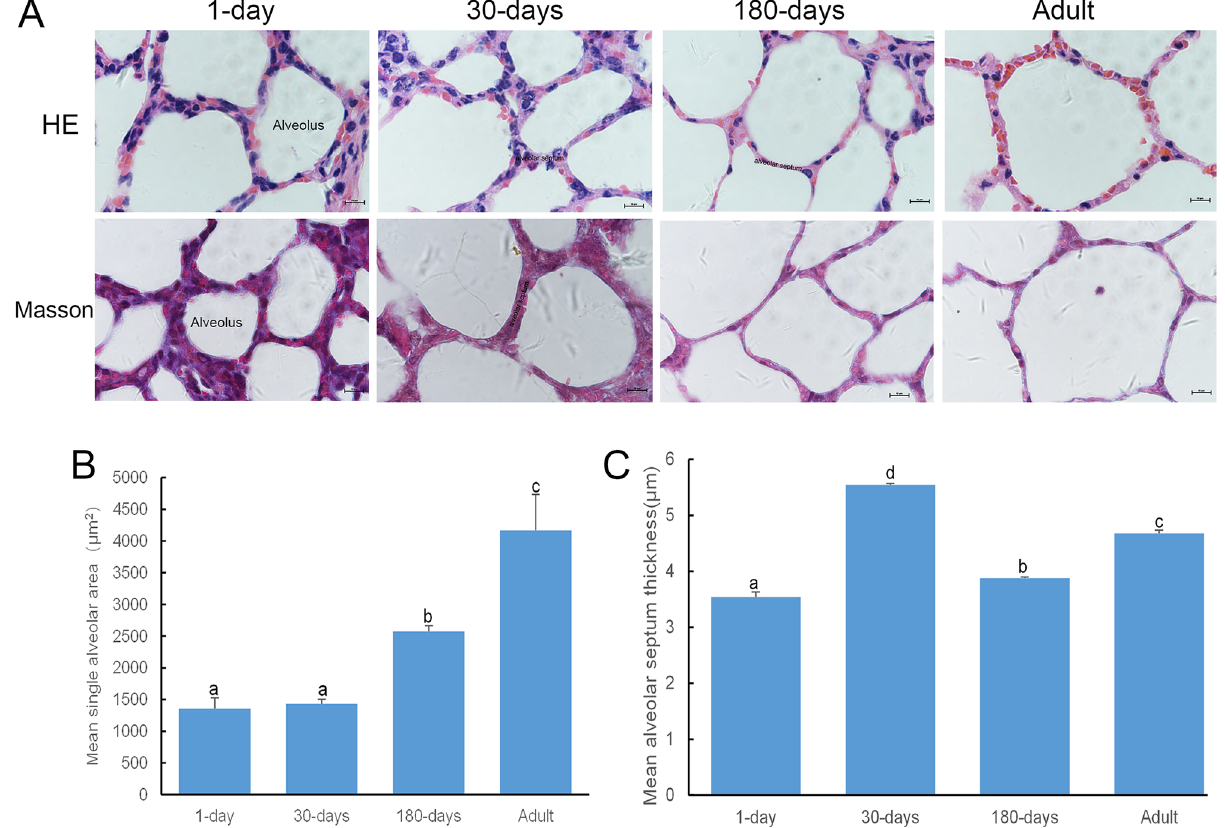
Figure 1. The microstructure of yak alveoli at different developmental stages observed using HE staining and Masson’s staining. ( A ) Representative sections from 1-day old animals to adults (scale bar represents 10 µm, 1000×). ( B ) Graph representing the mean area of individuals pulmonary alveoli ( C ) Graph representing the mean interalveolar septum thickness. Values represent the mean ± SD (n = 3). Different letters (a, b, c, and d) indicate significant differences ( P <